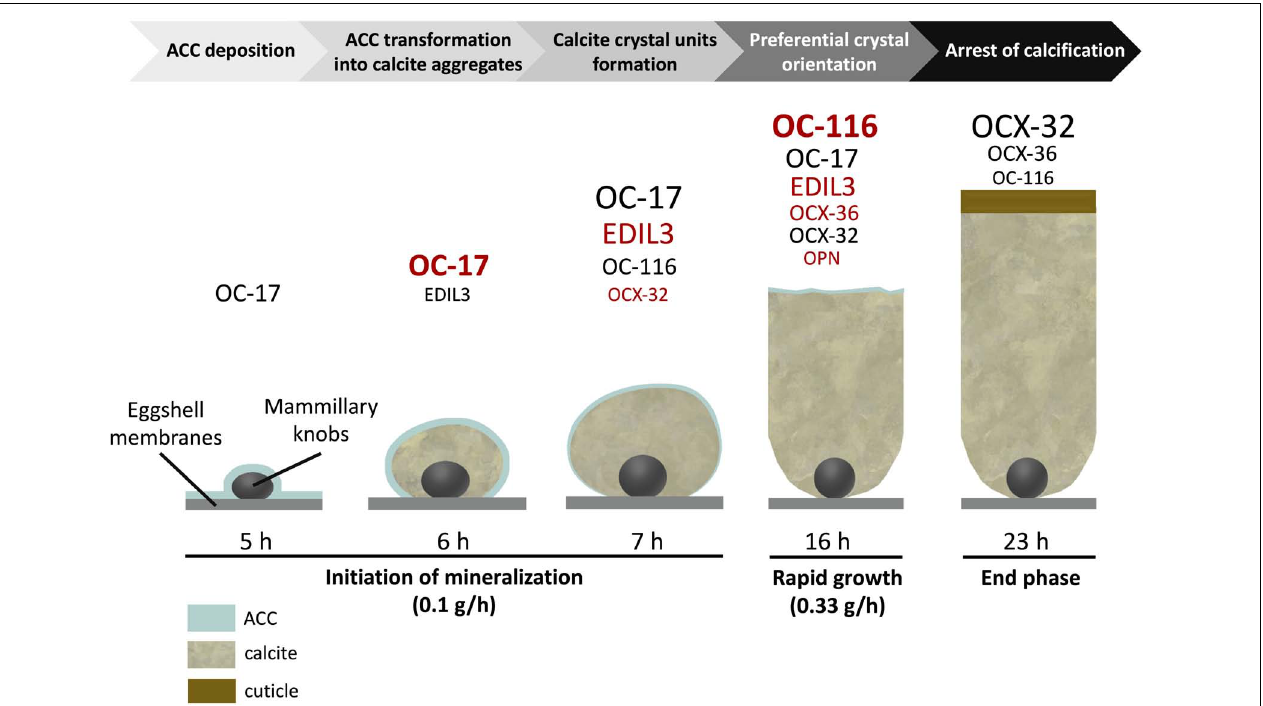
FIGURE 1 | Schematic representation illustrating the presence of the 6 major proteins at the key events of chicken eggshell mineralization adapted from Marie et al. (2015a) and Gautron et al. (2021). Size of characters is relative to their level at individual stages [based on hierarchical ranking of the emPAI value from Marie et al. (2015a) for stages from 5 to 16 h and from Rose-Martel et al. (2012) – cuticle proteome – for the stage 23 h]. Overabundant proteins at each stage are indicated in red [based on spectral counting label free quantitative method and ANOVA statistical analysis from Marie et al. (2015a)].